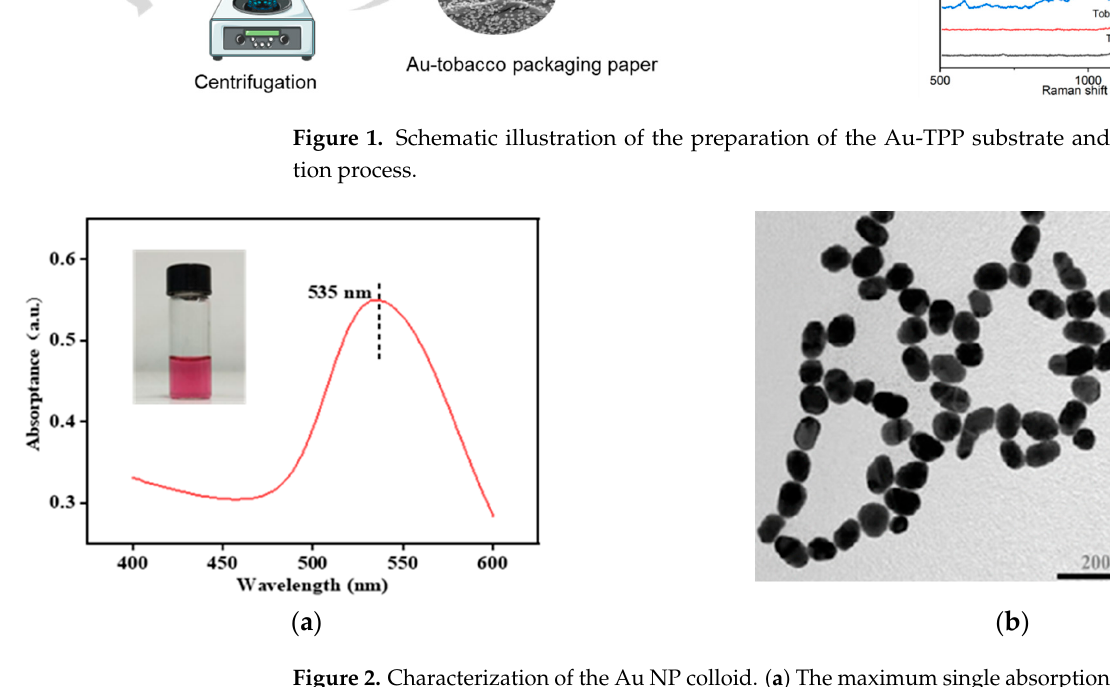
Figure 2. Characterization of the Au NP colloid. ( a ) The maximum single absorption peak of colloidal Au NPs is near 535 nm; ( b ) TEM image of Au